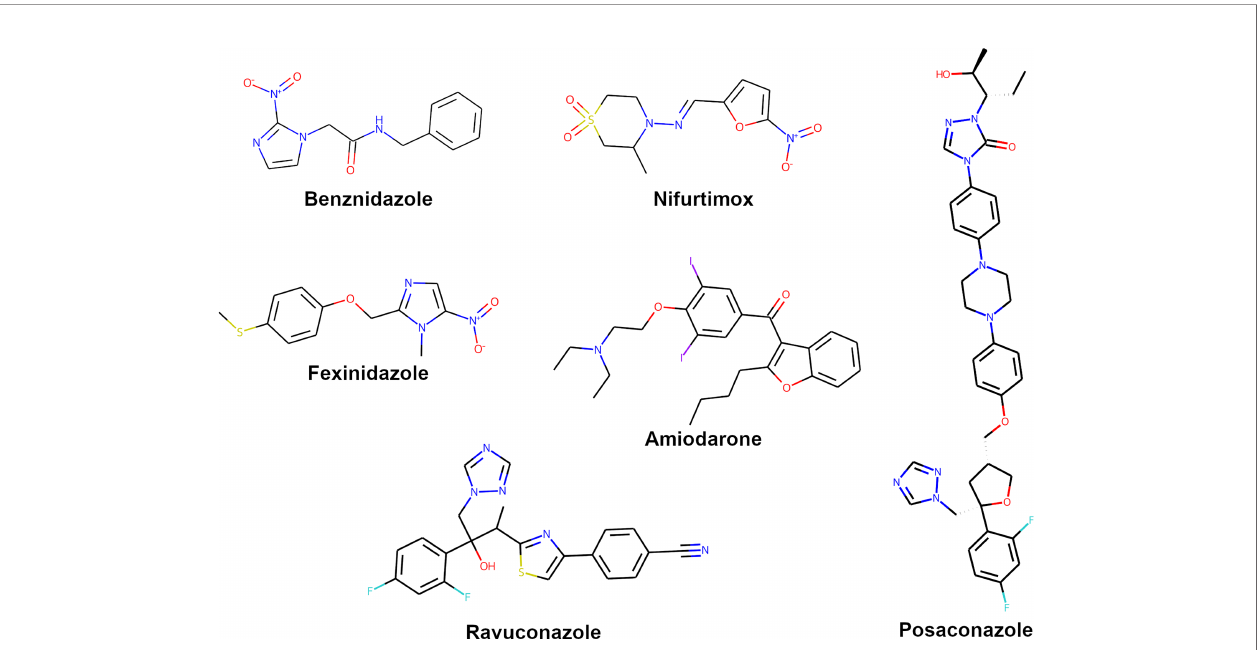
FIGURE 2 | Structures of compounds with anti- T.cruzi activity used in clinical trials.